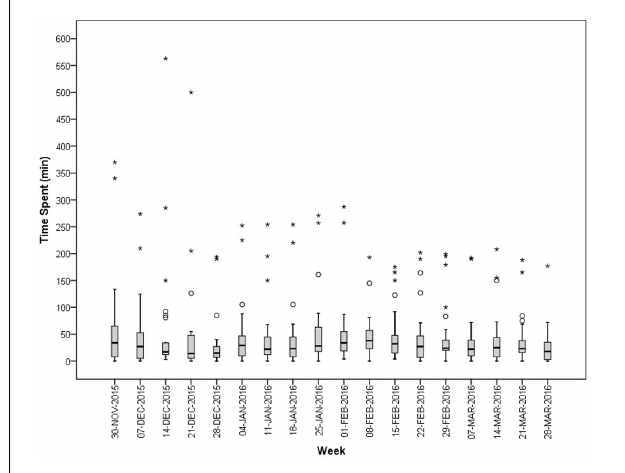
FIGURE 2 | Median (IQR) time spent (in min) per week on supply problems by community pharmacies in Flanders ( N = 25). ◦ = outlier [1.5 IQR – 3 IQR]; ∗ = extreme ( > 3